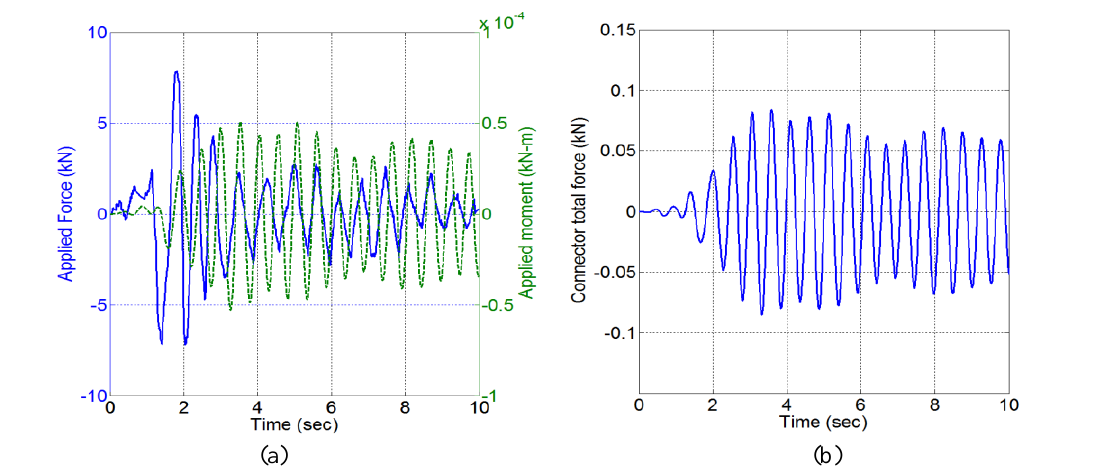
Figure 10. (a) Applied Force history at the base and (b) total force in Structure